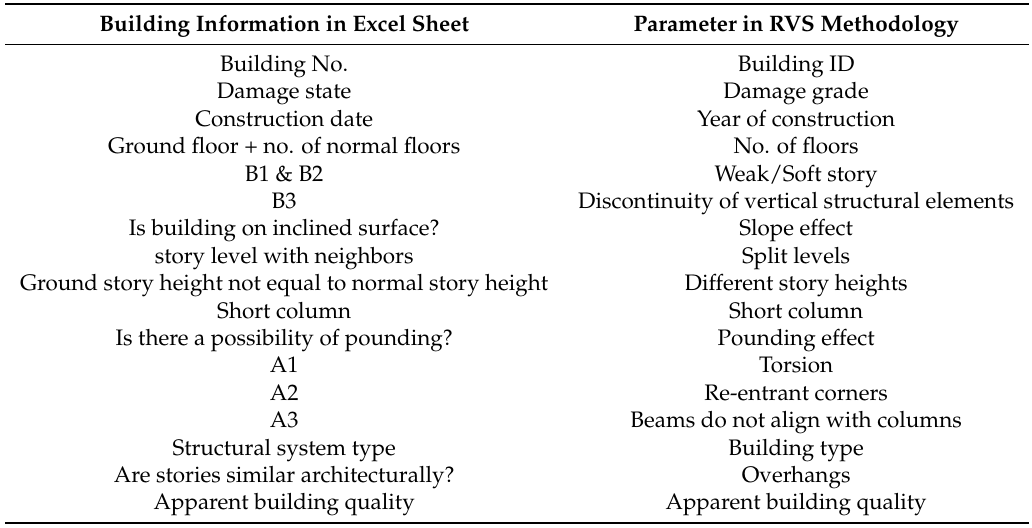
Table 7. Collected information from a street survey performed by a Middle East Technical University (METU) research team [29,33].